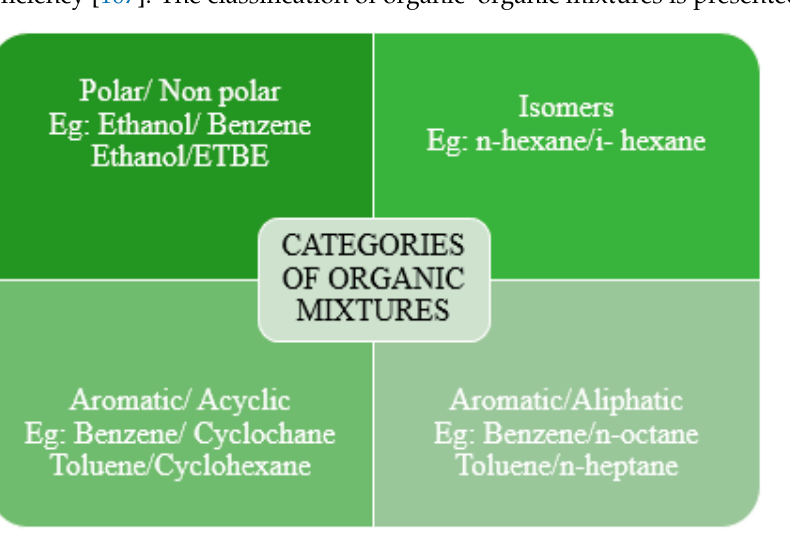
Figure 9. Classification of organic–organic mixtures.